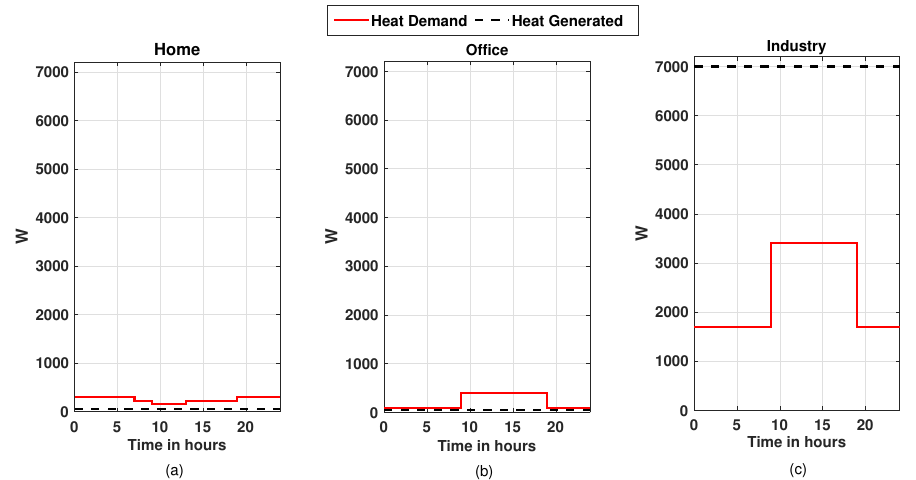
Figure 9. Heating demand and generation of 24 h for the month of June, ( a ) for the home building, ( b ) for office building, and ( c ) for industry building.